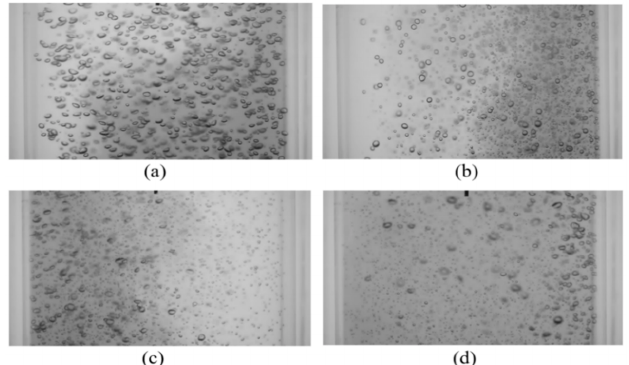
Figure 15. Instantaneous images of mixing at t = 10 s with various vibration amplitudes ( f = 9.5 Hz, U SG = 11 mm / s) for ( a ) A = 0.6 mm, P m = 0.146 W / kg; ( b ) A = 1.2 mm, P m = 0.261 W / kg; ( c ) A = 1.9 mm, P m = 0.492 W / kg; ( d ) A = 3.3 mm, P m = 1.266 W / kg. Fluids 2020 , 5 , x